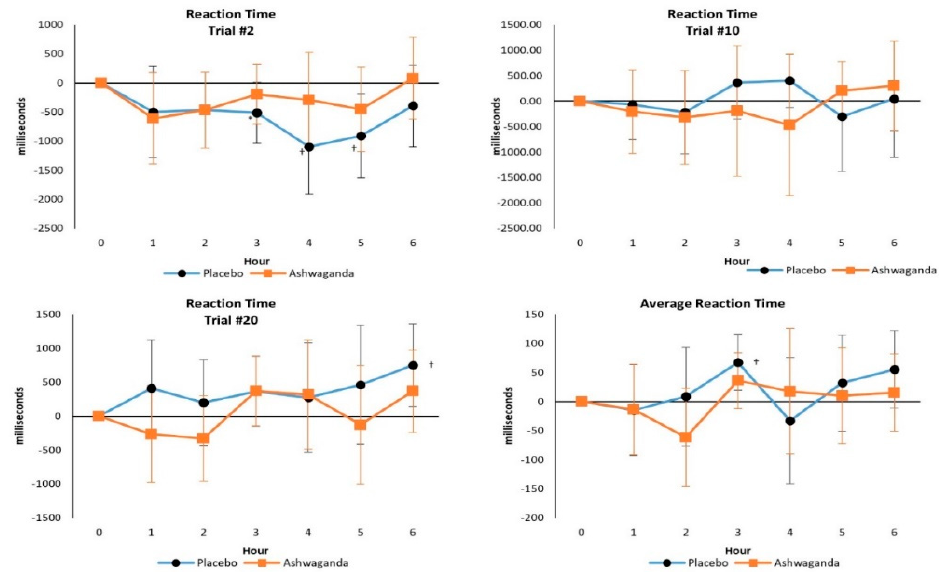
Figure 6. Psychomotor Vigilance Task Test results. Data are mean differences from baseline with 95% confidence intervals. † indicates p < 0.05 difference from baseline values. * indicates p > 0.05 to p < 0.10 difference between treatments.